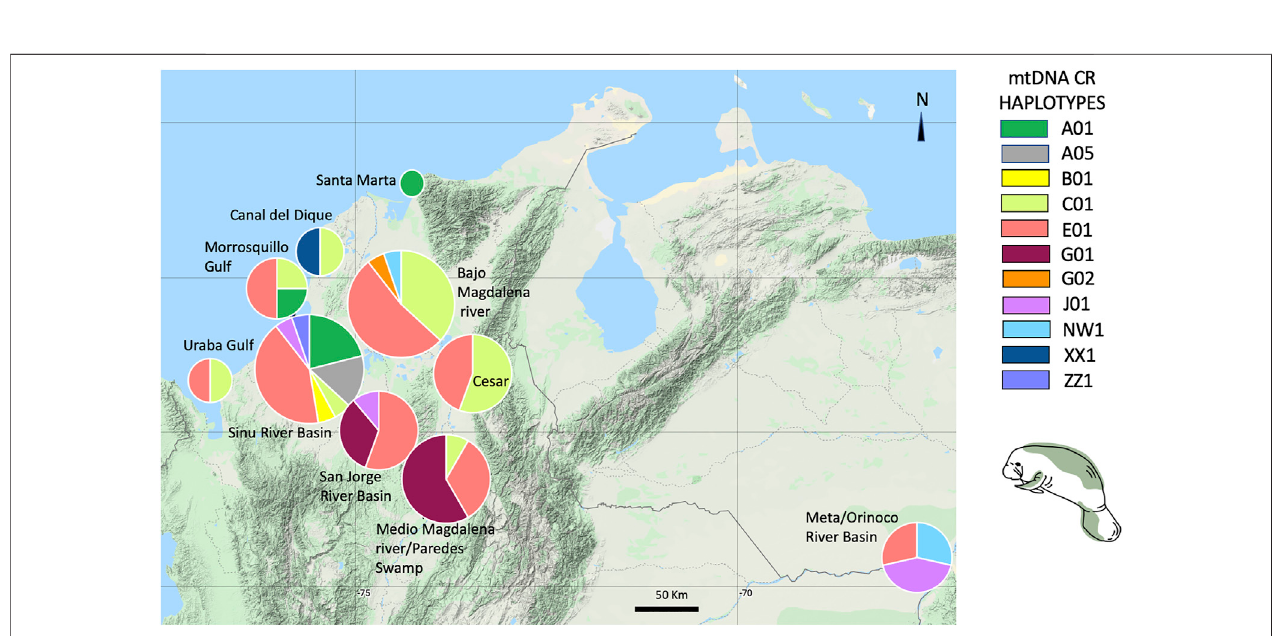
FIGURE 4 | Trichechus manatus mtDNA Control region haplotypes and their frequencies found in each Colombian sampling location included in this study.